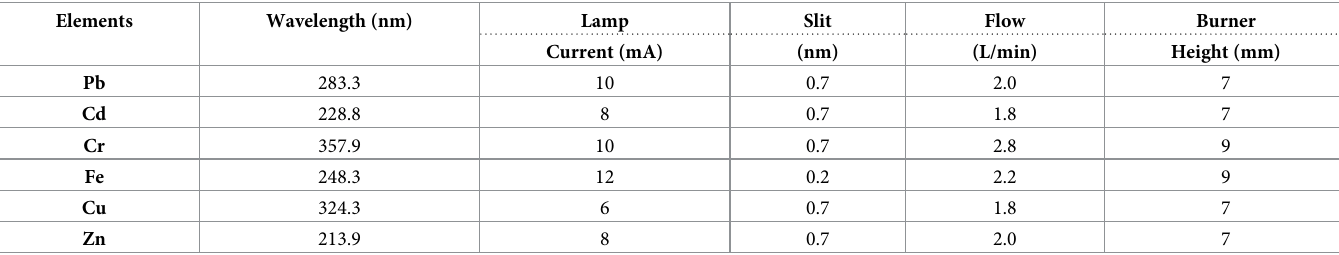
Table 1. The wavelength, slit length, flame type, flow rate, and burner height of each metal. Elements Wavelength (nm) Lamp Slit Flow Burner Current (mA) (nm) (L/min) Height (mm) Pb 283.3 10 0.7 Cd 228.8 Cr 357.9 Fe 248.3 12 0.2 Cu 324.3 Zn